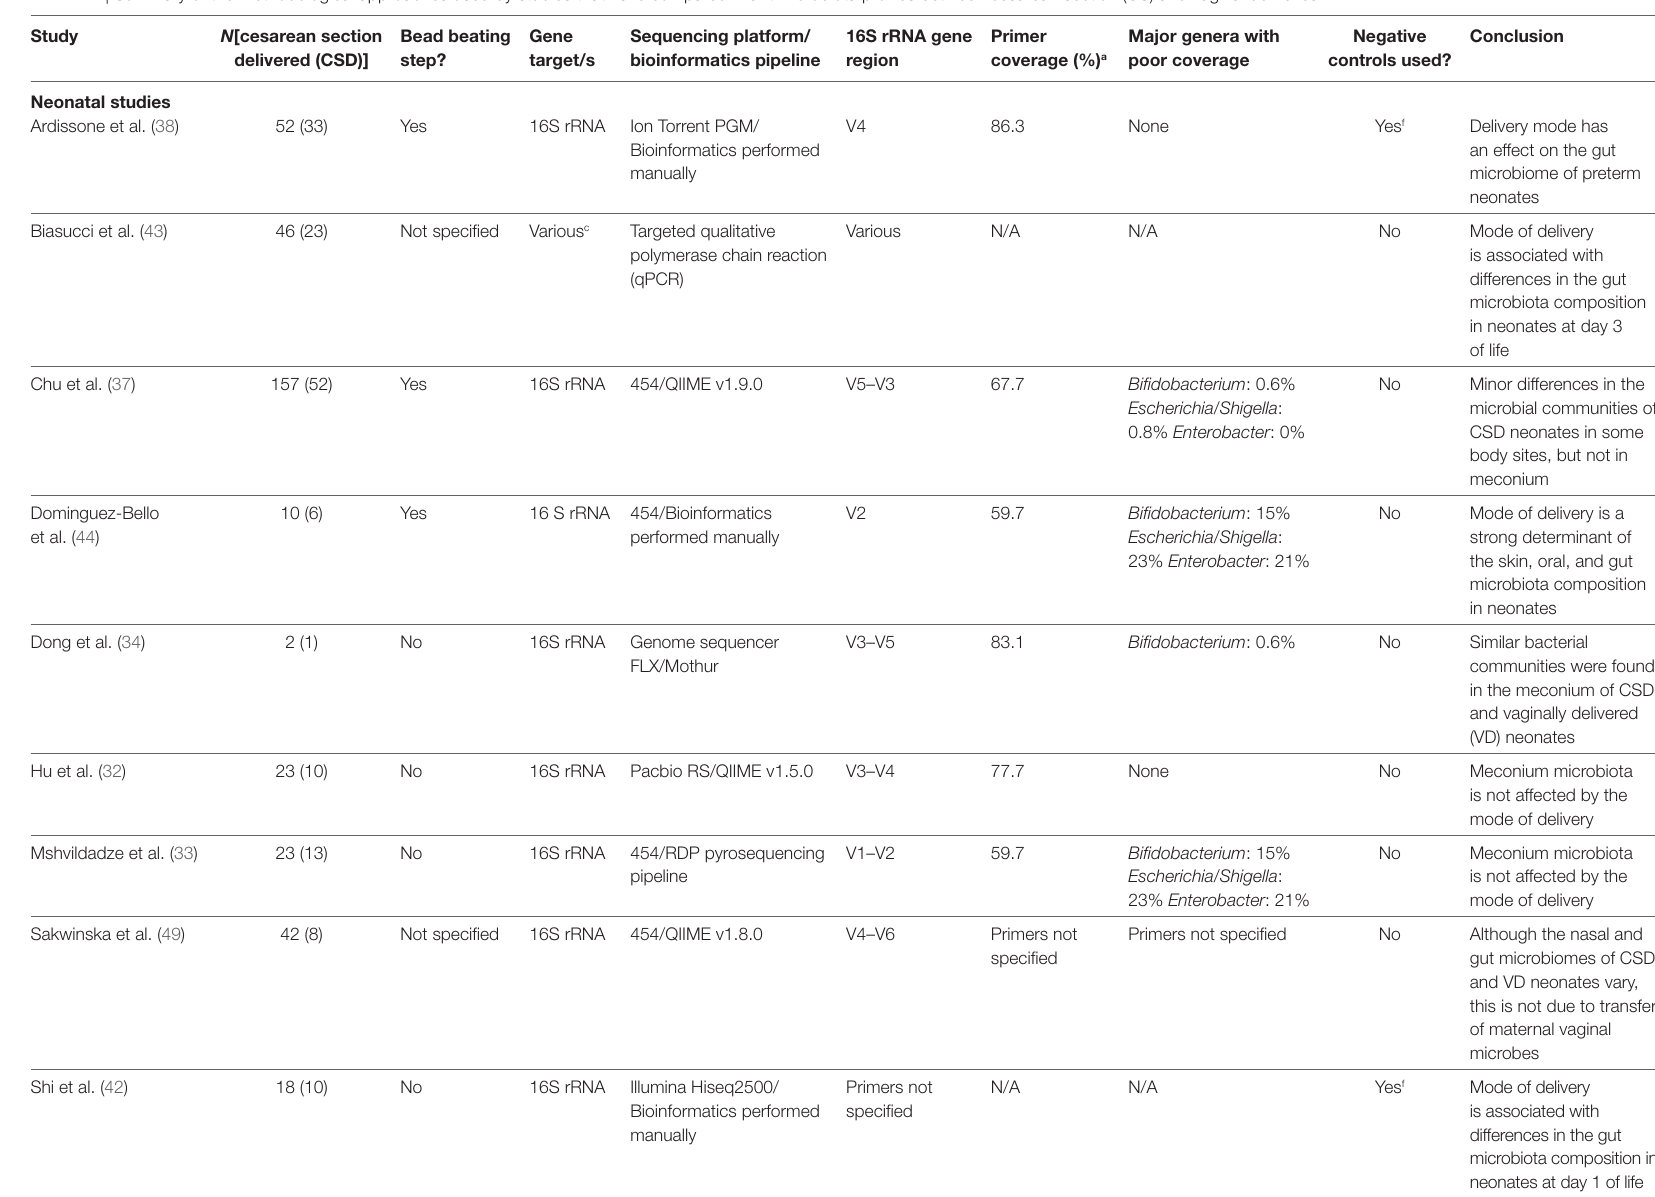
TABLe 1 | Summary of the methodological approaches used by studies that have compared infant microbiota profiles between cesarean section (CS) and vaginal deliveries.